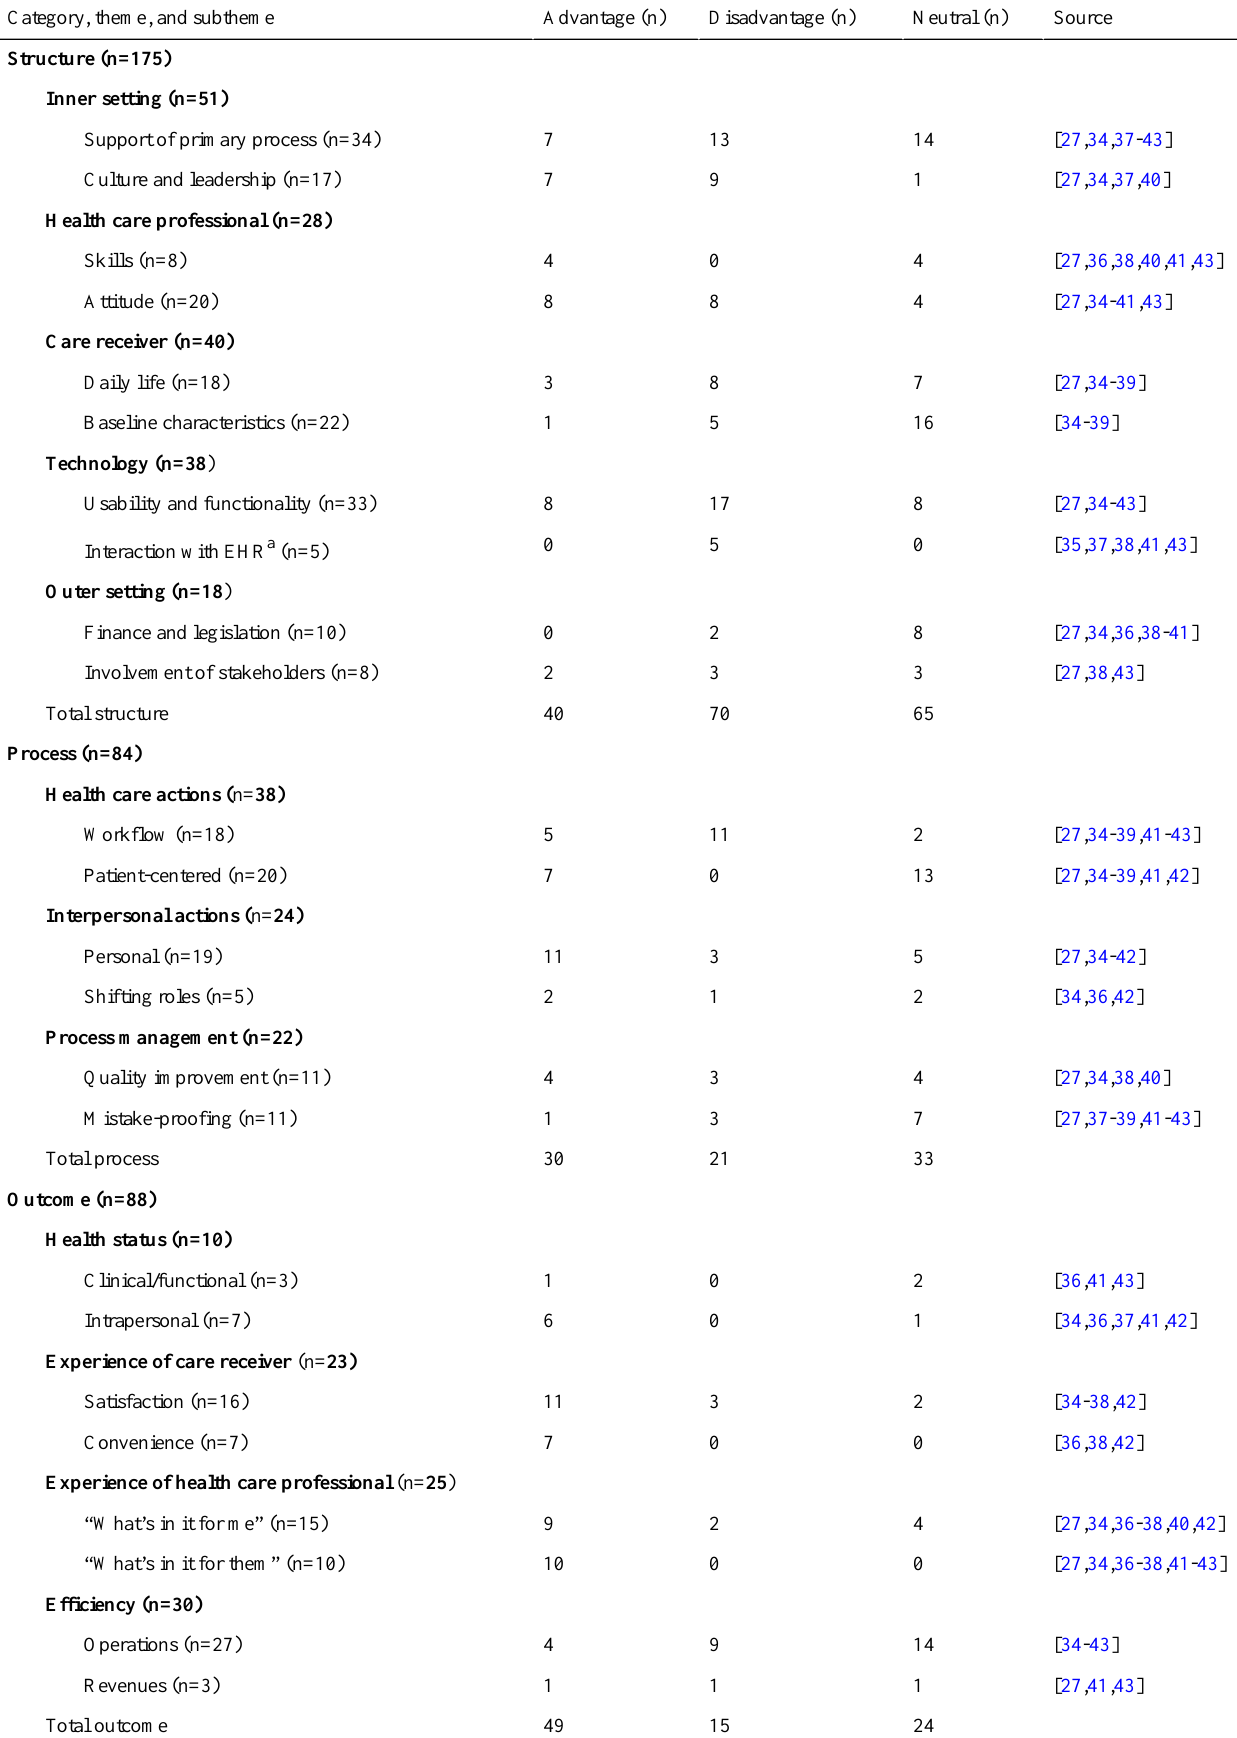
Table 4. Distribution of the indicators according to the themes and subthemes of the structure, process, and outcome